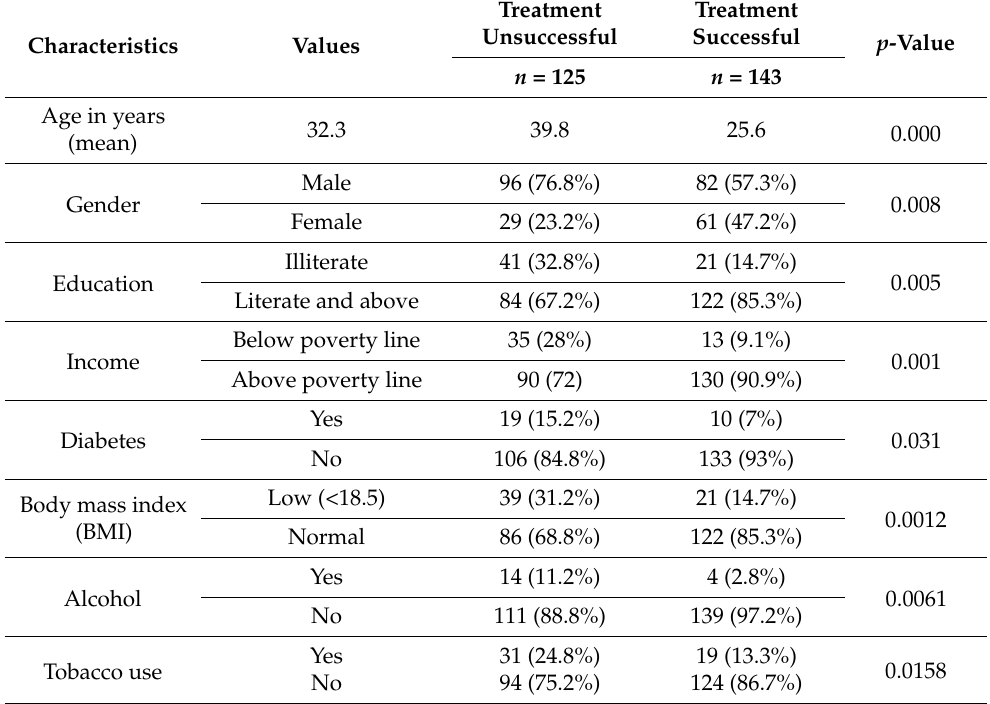
Table 5. Associations between background characteristics and treatment outcomes ( n =